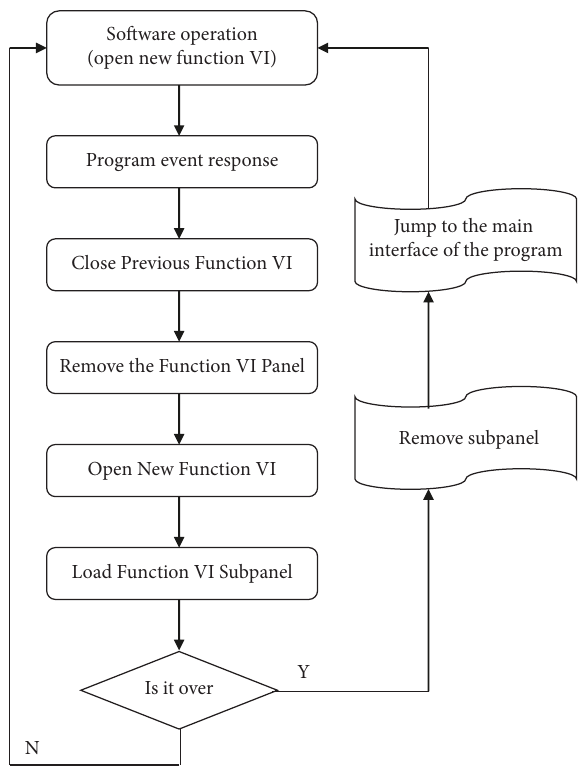
Figure 4: Operation logic of software activity